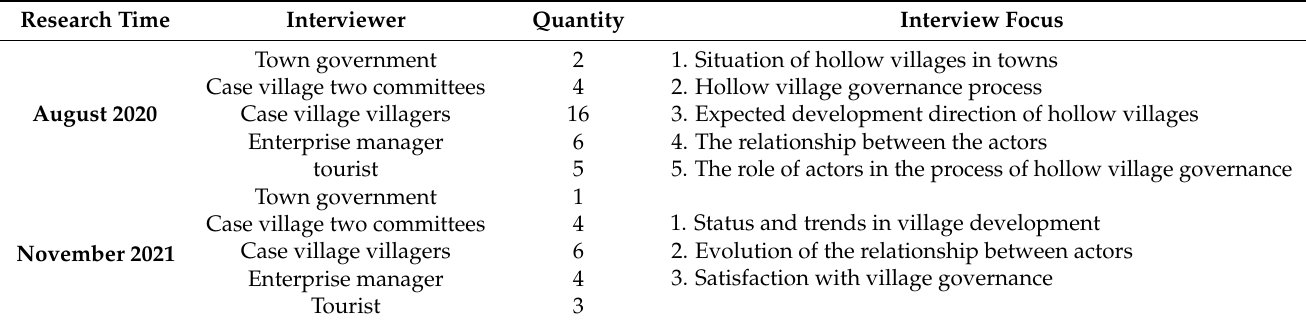
Table 1. Research objects and interview